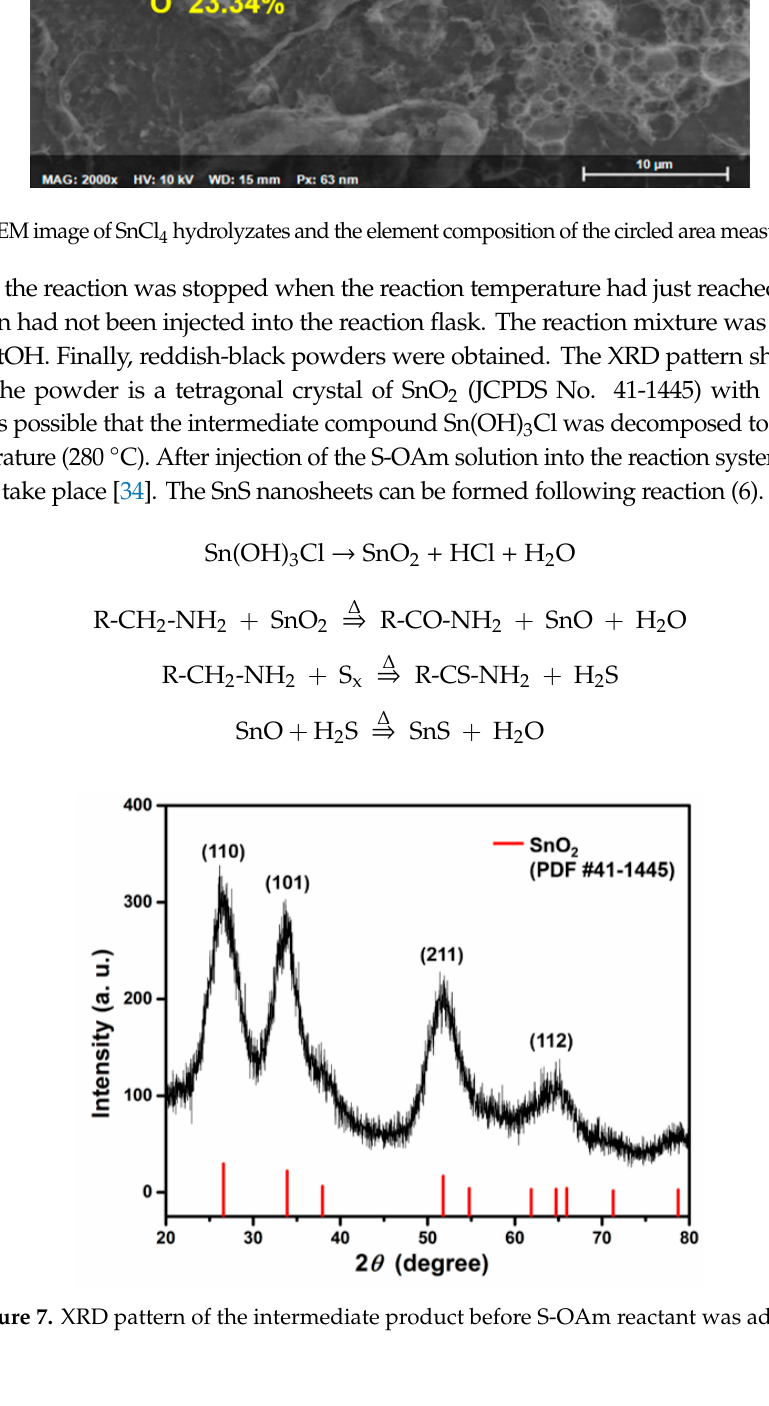
Figure 7. XRD pattern of the intermediate product before S-OAm reactant was